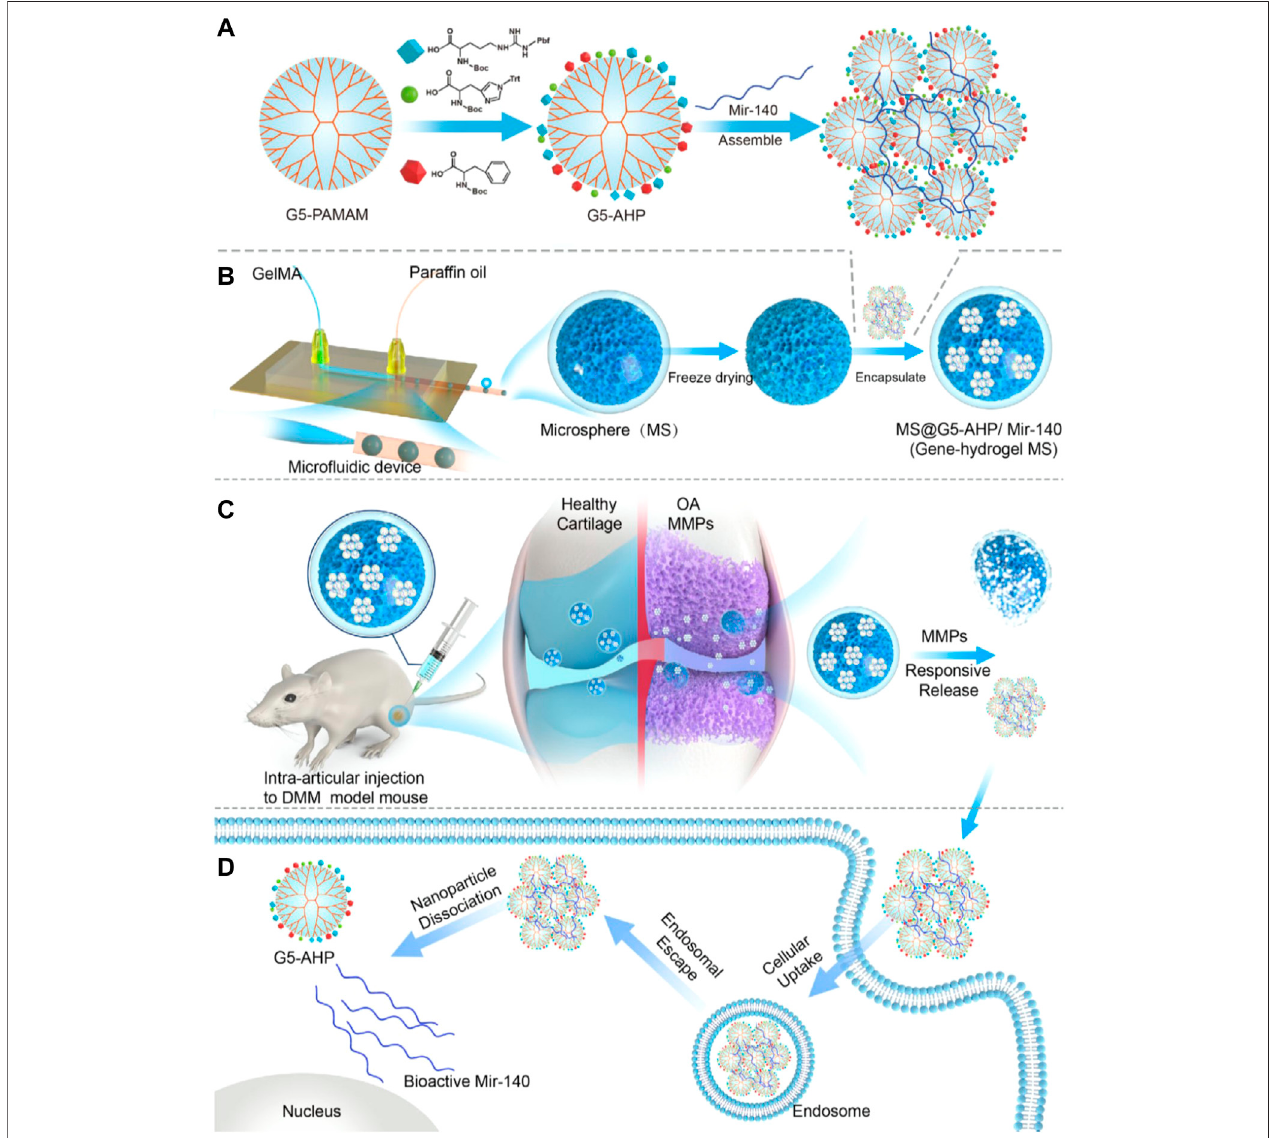
FIGURE 3 | Gene-hydrogel microspheres for the treatment of OA. (A) preparation of G5-AHP and G5-AHP/miR-140. (B) Gene-hydrogel MSs. (C) Injection with MS@G5-AHP/miR-140 into the articular space to alleviate the progression of OA. (D) Endocytosis of G5-AHP/miR-140 polyplexes and the release of miR-140. Reproduced with permission (Li B, 2022). Copyright 2022, Nature Publishing